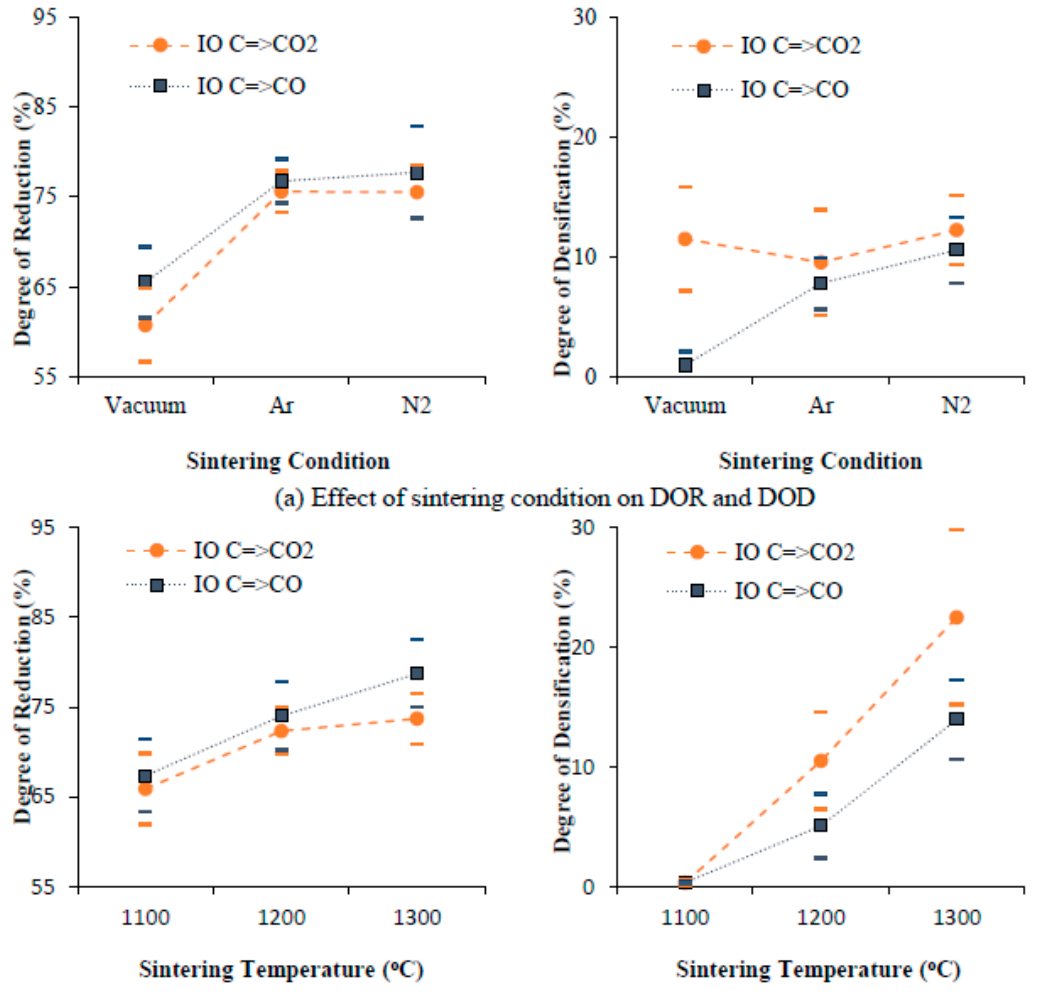
Figure 13. Main effects on the degree of reduction and densification of iron ore of( a ) sintering condition and ( b ) sintering temperature.